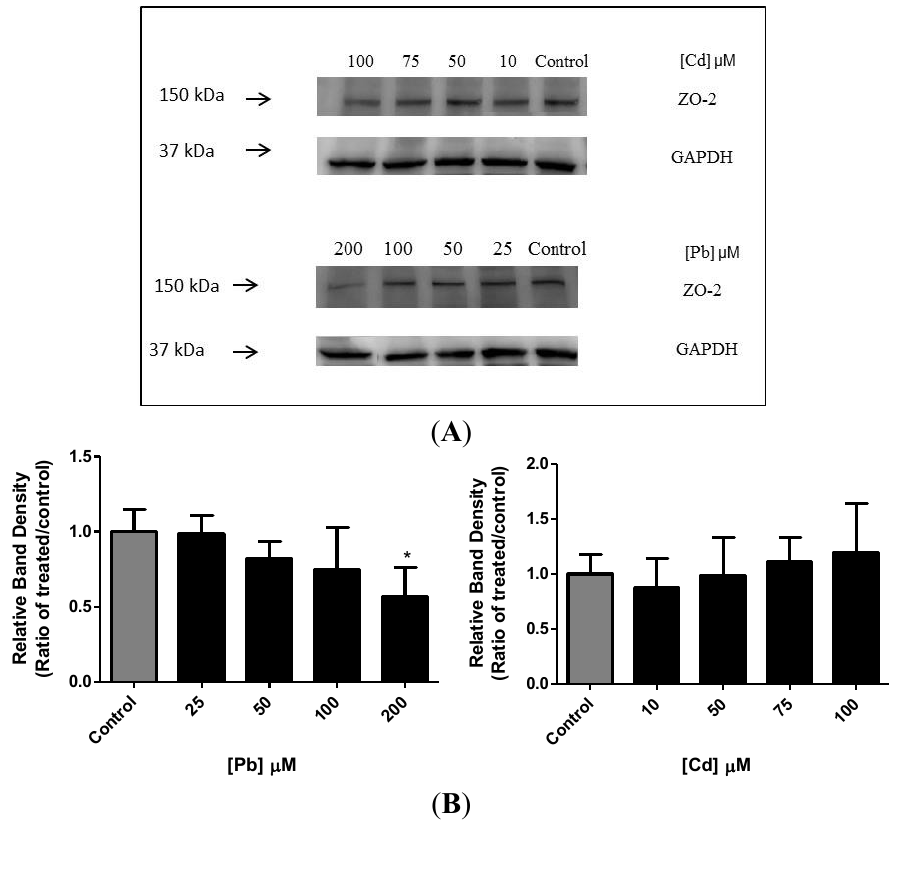
Figure 7. ( A ) Effect of Pb and Cd on tight junction protein: ZO-2. Shown are the representative Western blots of ZO-2 in hCMEC/D3 cells treated with different concentrations of Pb (25–200 µM) and Cd (10–100 µM) for 48 h and 24 h, respectively. ( B ) The graphs represent relative densitometric analysis of treated cells over the controls. The results are representative of three individual experiments. * Values significantly different from